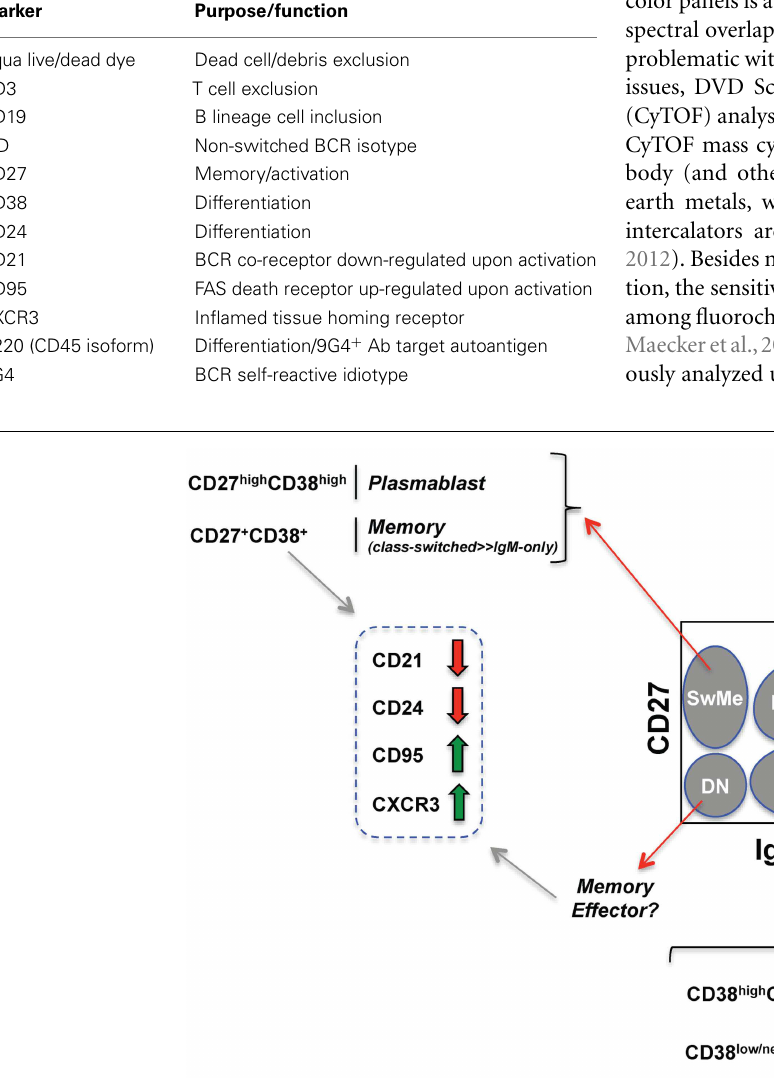
into transitional and mature-naïve B cells. DistinguishingT3 from mature-naïve requires a mitochondrial dye extrusion step not included in the memory B cell panel.The switched memory and CD27 + /int memory-phenotype core subsets can be further evaluated for changes ( thick red and green arrows ) in the indicated markers known to be associated with B cell